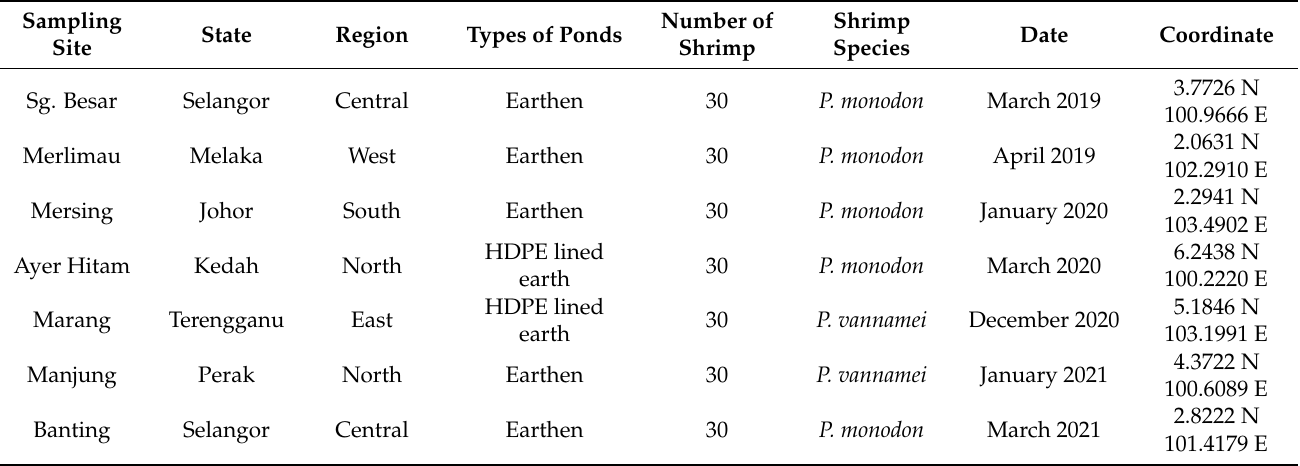
Table 1. Shrimp sampling data from seven shrimp farms in different geographical regions of Penin- sular